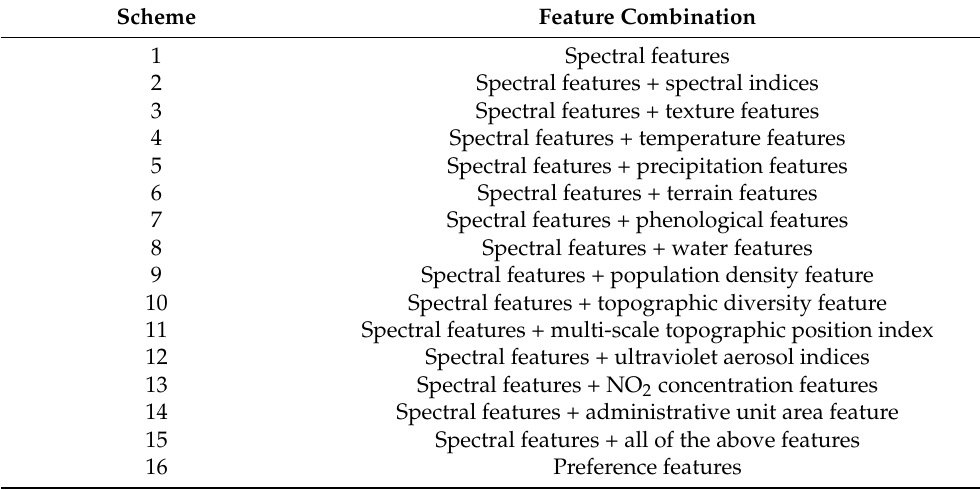
Table 3. Sixteen combination schemes of different